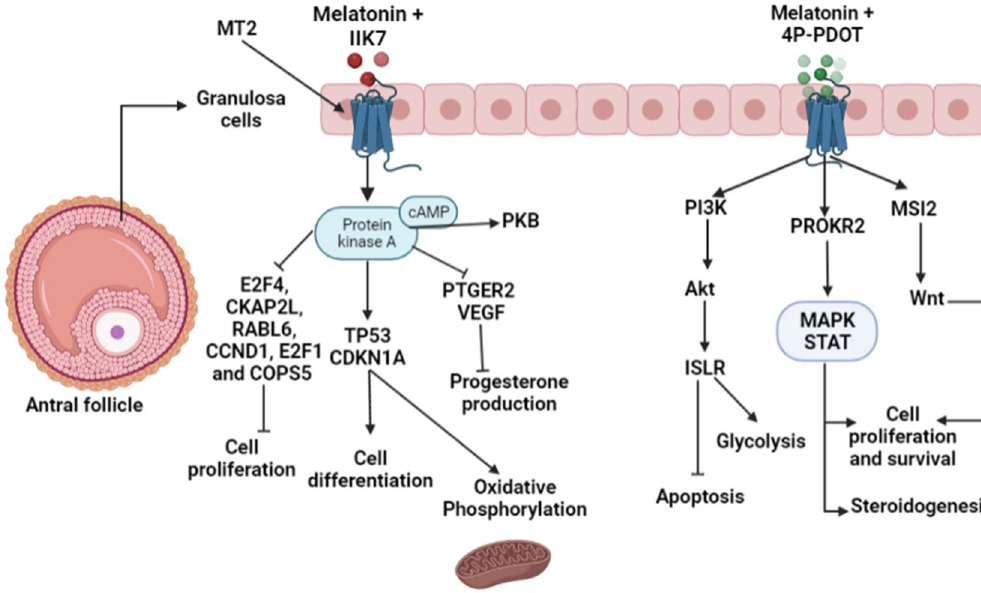
Figure 2. Effects of MT2 receptor activation or knockdown on the response of human granulosa cells to melatonin (generated by BioRender, https:// biore nder.